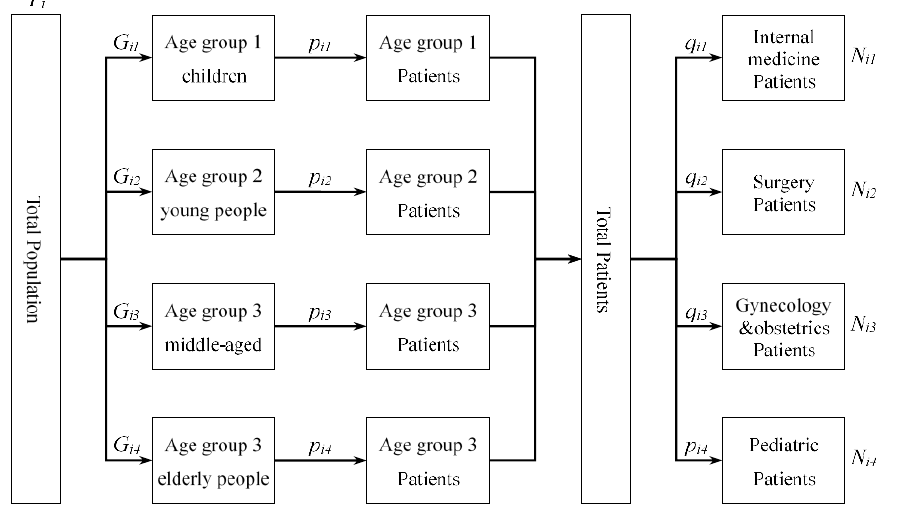
Figure 2. Calculation process for patients of the four types of medical services.